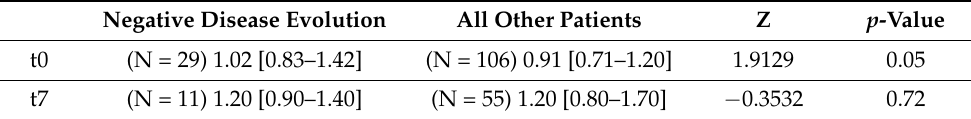
Table 3. Comparison of plasma CGRP levels (ng/mL) at baseline (t0) and after 7 days (t7) of hospitalization between patients with negative disease evolution (in-hospital death or ICU admission) vs. all other patients. Values are expressed as median (IQR). Bold text highlights the statistically significant results. N = number of analyzed patients.